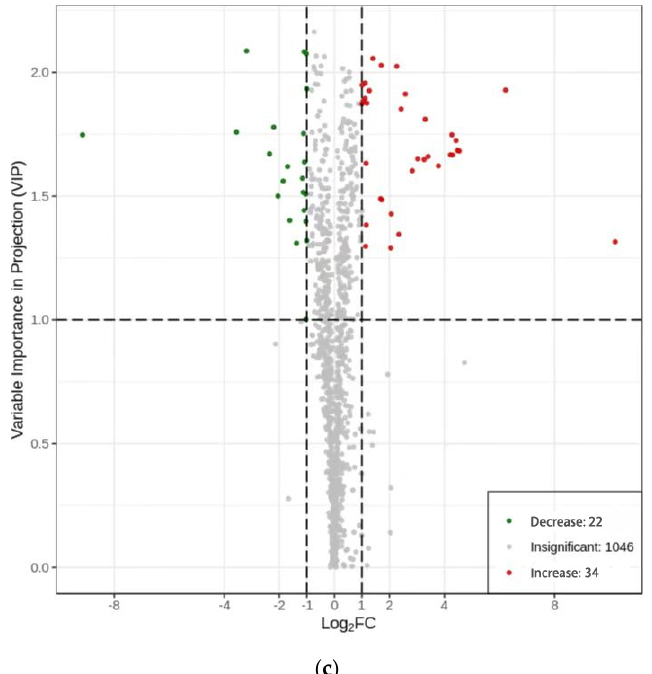
Figure 2. Differentially accumulated metabolite analysis: ( a ) heatmap visualization of the differen- tially accumulated metabolites identified between P. amarus bamboo shoots grown under shading treatment and normal growing conditions; BGM: shading group, ZRM: control group; ( b ) pie chart of the biochemical categories of the differentially accumulated metabolites identified between P. amarus bamboo shoots grown under shading treatment and normal growing conditions; ( c ) volcano plot of the differentially accumulated metabolites identified between P. amarus bamboo shoots grown under shading treatment and normal growing conditions.